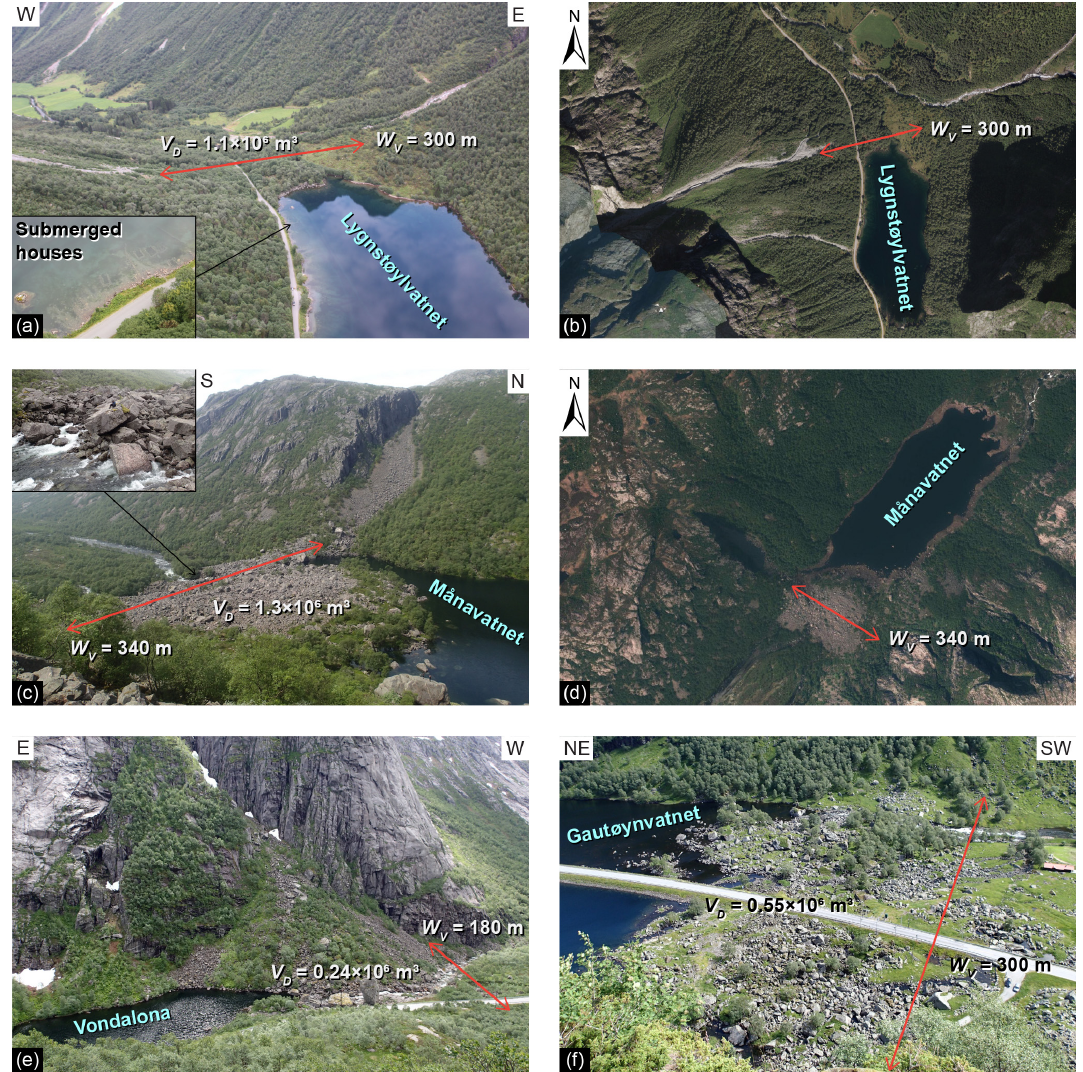
Figure 1. Photographs of RSF dams in southwestern Norway with dam volume V D and valley width W V . (a) The lake Lyngstøylvatnet was created by the 1908 rock avalanche from the mountain Keipen in the west. The rock avalanche went over an existing debris cone and abutted against a debris cone on the opposite valley side, leading to a type IIb dam that is intact (dam classification by Hermanns et al., 2011b). The remains of submerged houses are visible in Lyngstøylvatnet (inset). (b) Orthophoto of Lyngstøylvatnet (Norwegian Mapping Authority, 2020b). (c) The lake Månavatnet was dammed by a 1 . 3 × 10 6 m 3 rock avalanche coming from the northwest. The type IIa dam has been stable until now with drainage through the rock avalanche deposits (inset). (d) Orthophoto of Månavatnet (Norwegian Mapping Authority, 2020b). (e) The lake Vondalona was created by a small rock avalanche in the narrow valley and the type IIc dam is partly eroded by the river. (f) The lake Gautøynvatnet is located only 3.7km downstream of lake Vondalona and was dammed by a 0 . 55 × 10 6 m 3 rock avalanche that completely crossed the valley. The type IIa dam is partly eroded by the